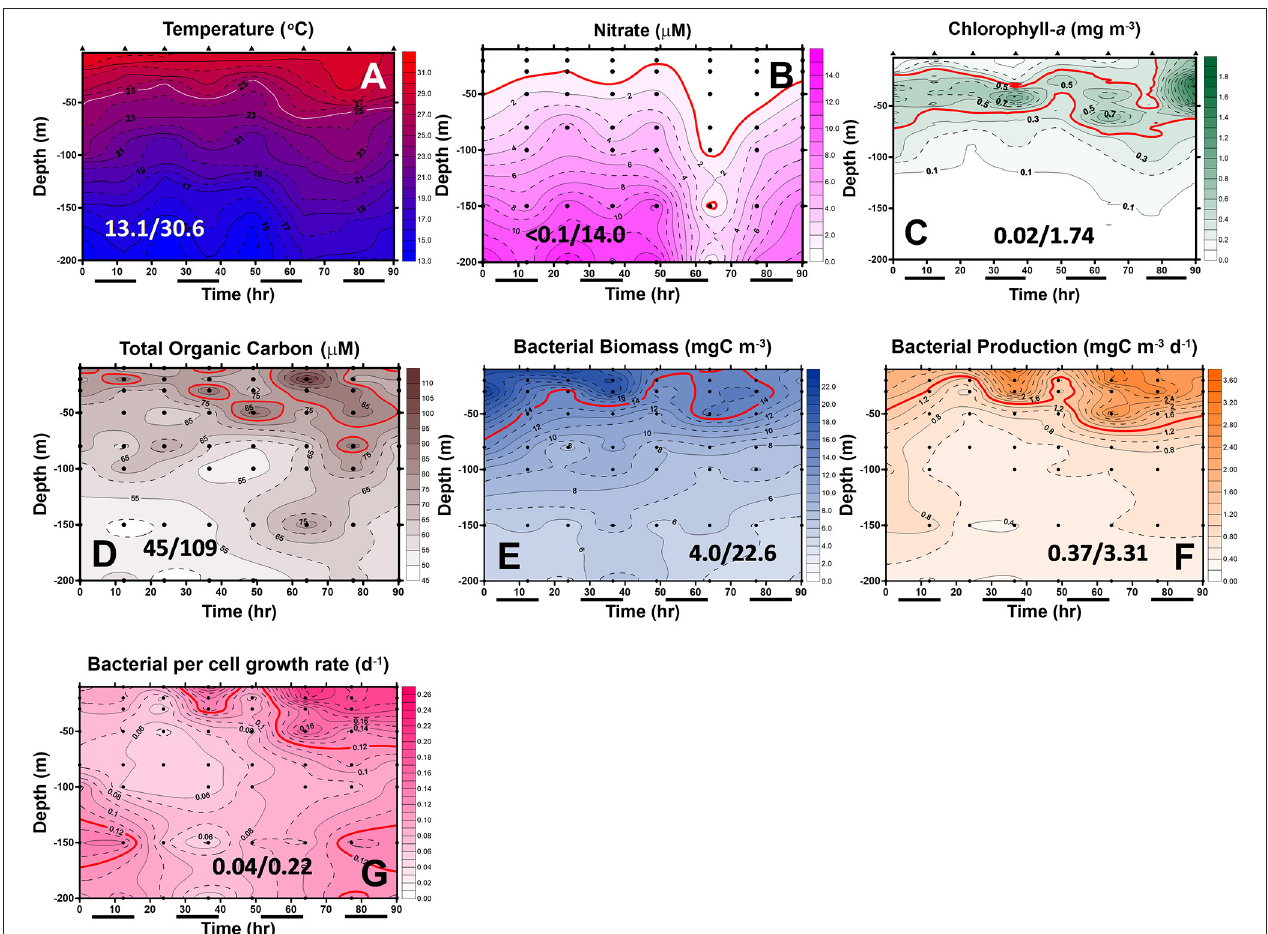
FIGURE 7 | Diel changes of the contour plots of the measurements in the upper 200m of station 2 of the July cruise. The values in slash indicate the minimum and maximum in each panel. The lines in (D–G) represent the isovalue lines of 80 µ MC TOC, 14 mgC/m 3 BB, 1.4 mgC/m 3 /day BP, and 0.12 B µ per day, respectively. The isovalue lines for (A–C) are the same as mentioned in Figure 5 . Black bars below the X -axis denote